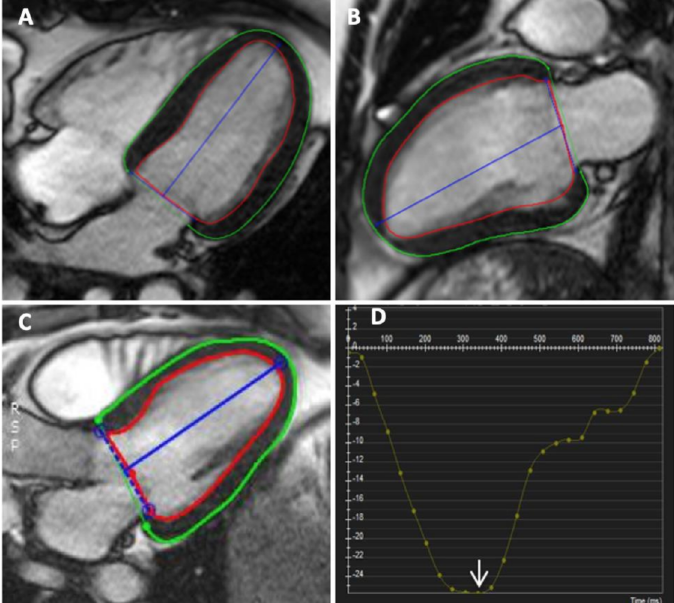
Figure 6. Long axis CMR assessment of 2D-strain using feature tracking by manually contouring endocardial and epicardial borders in end-diastole. ( A ): apical 4-chamber view, ( B ): apical 2-chamber view, ( C ): apical 3-chamber view, ( D ): myocardial strain curve with normal peak GLS measured ( − 26%).